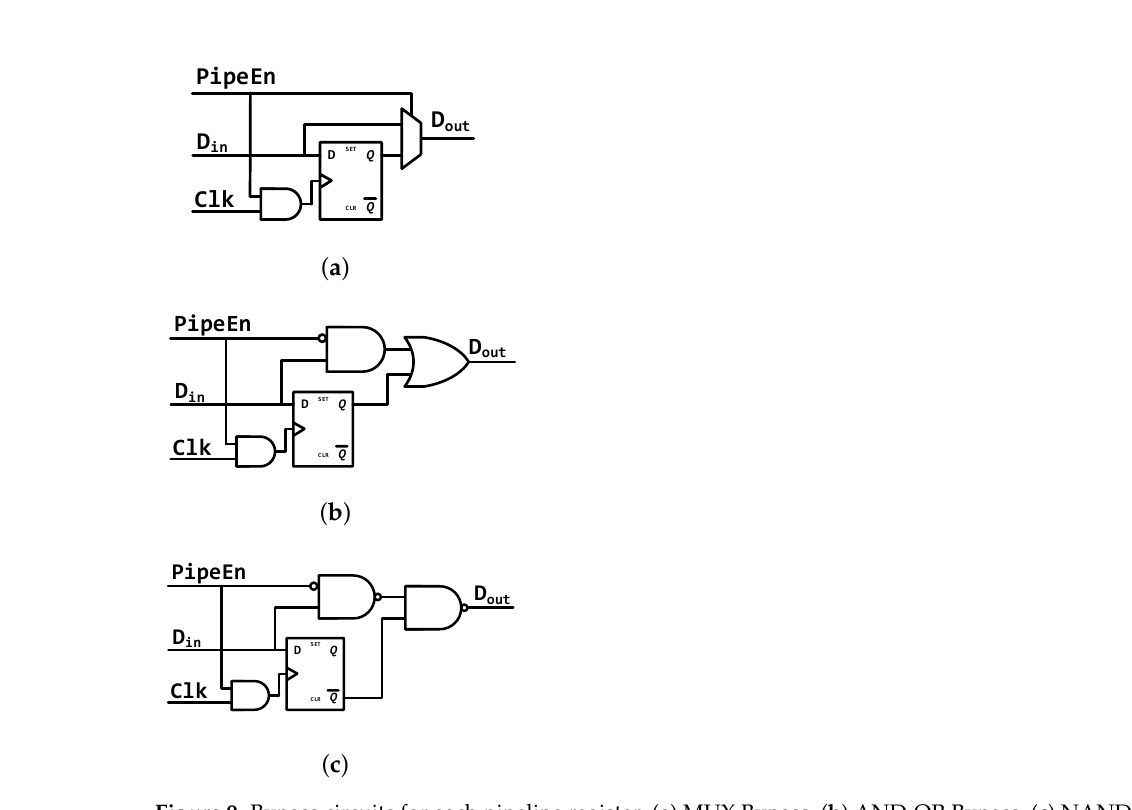
Figure 9. Bypass circuits for each pipeline register. ( a ) MUX Bypass, ( b ) AND-OR Bypass, ( c ) NAND- NAND